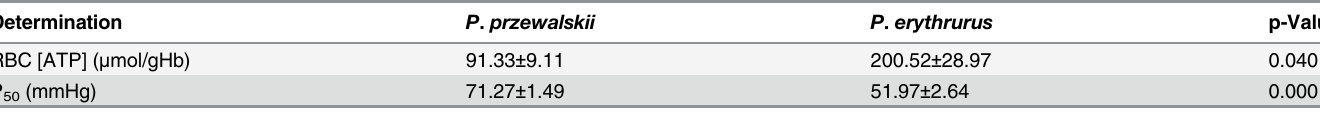
Table 5. ATP concentration and P 50 of P . erythrurus and P . przewalskii .